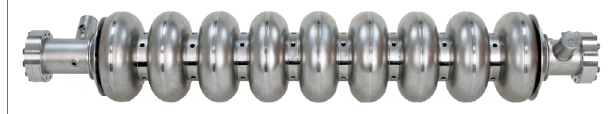
FIGURE 2 | 1.3 GHz nine-cell SRF TESLA cavity made of bulk niobium. Courtesy of